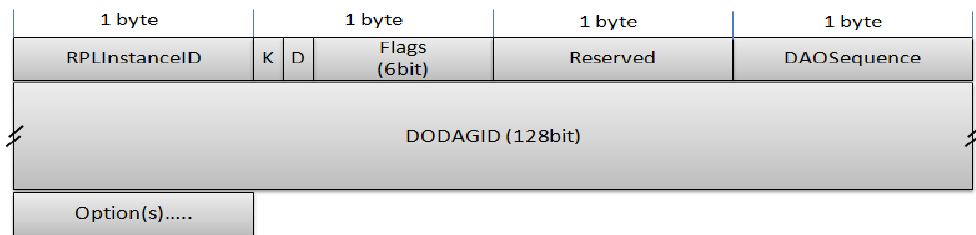
Figure 12. The DAO Base Object.